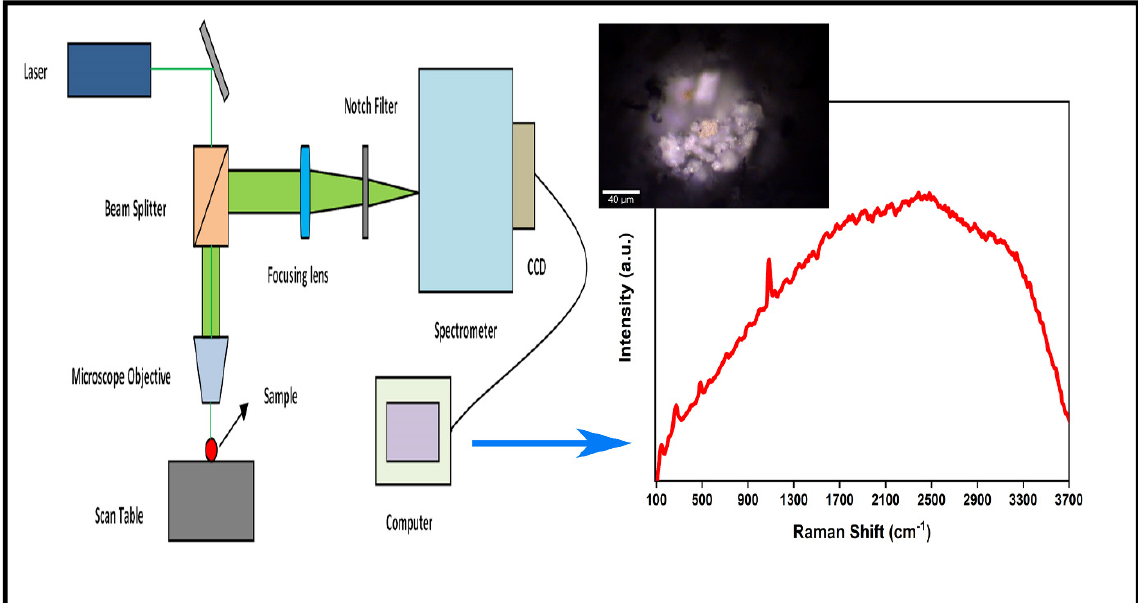
Figure 1. Schematic representation of micro-Raman spectroscope. The microscopic image (20 × ) and the Raman spectrum of a dust particle (calcite mineral - characteristic vibration: ~1085 cm -1 ).